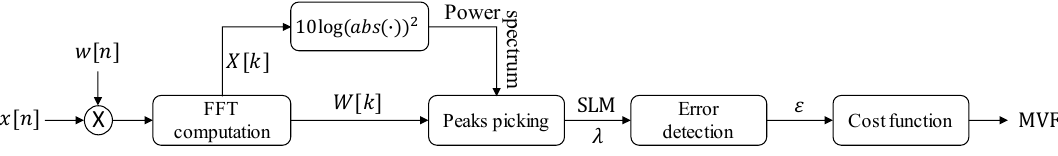
Figure 5. Workflow of the MVF estimation algorithm based on SLM method.